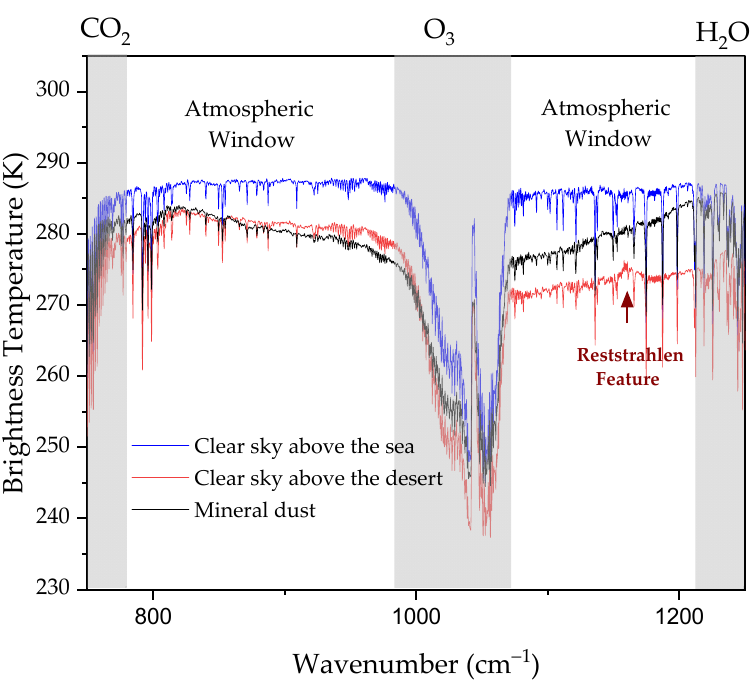
Figure 1. IASI detection spectra of a clear sky above the sea (in blue), a clear sky above the desert (in red) with a Reststrahlen feature, and mineral dust above the desert (in gray). Carbon dioxide, ozone, and water vapor absorption bands are presented in patterned regions, masking atmospheric detection.